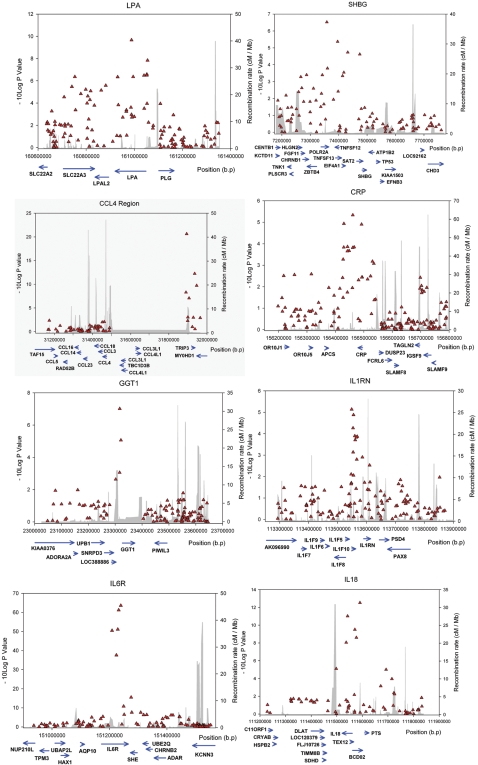

Cis genotype effects.X axis shows the distance on the relevant chromosome. Left hand Y axis shows the −log10 p values and right hand Y axis shows the recombination rate as calculated from HapMap data.